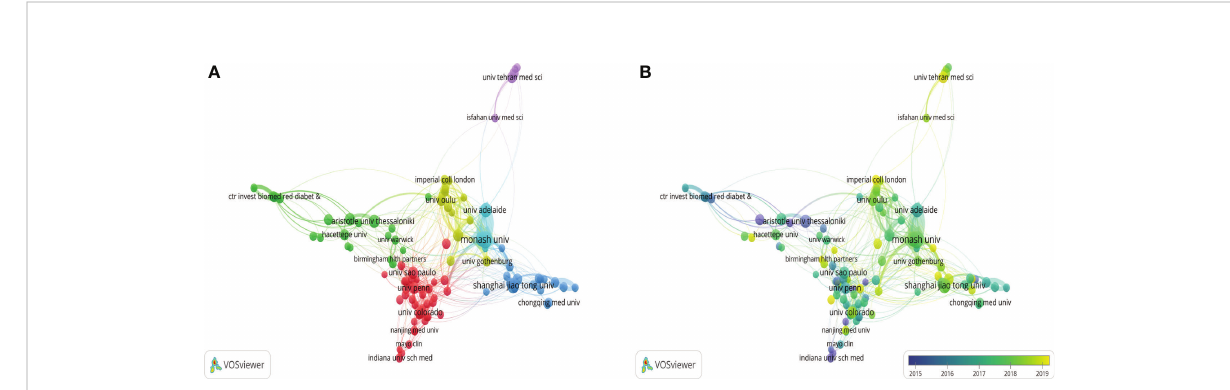
FIGURE 5 Visualization map of universities and institutions. (A) Network diagram of the top 100 universities/institutions. (B) Dynamics and trends of the top 100 universities/institutions.